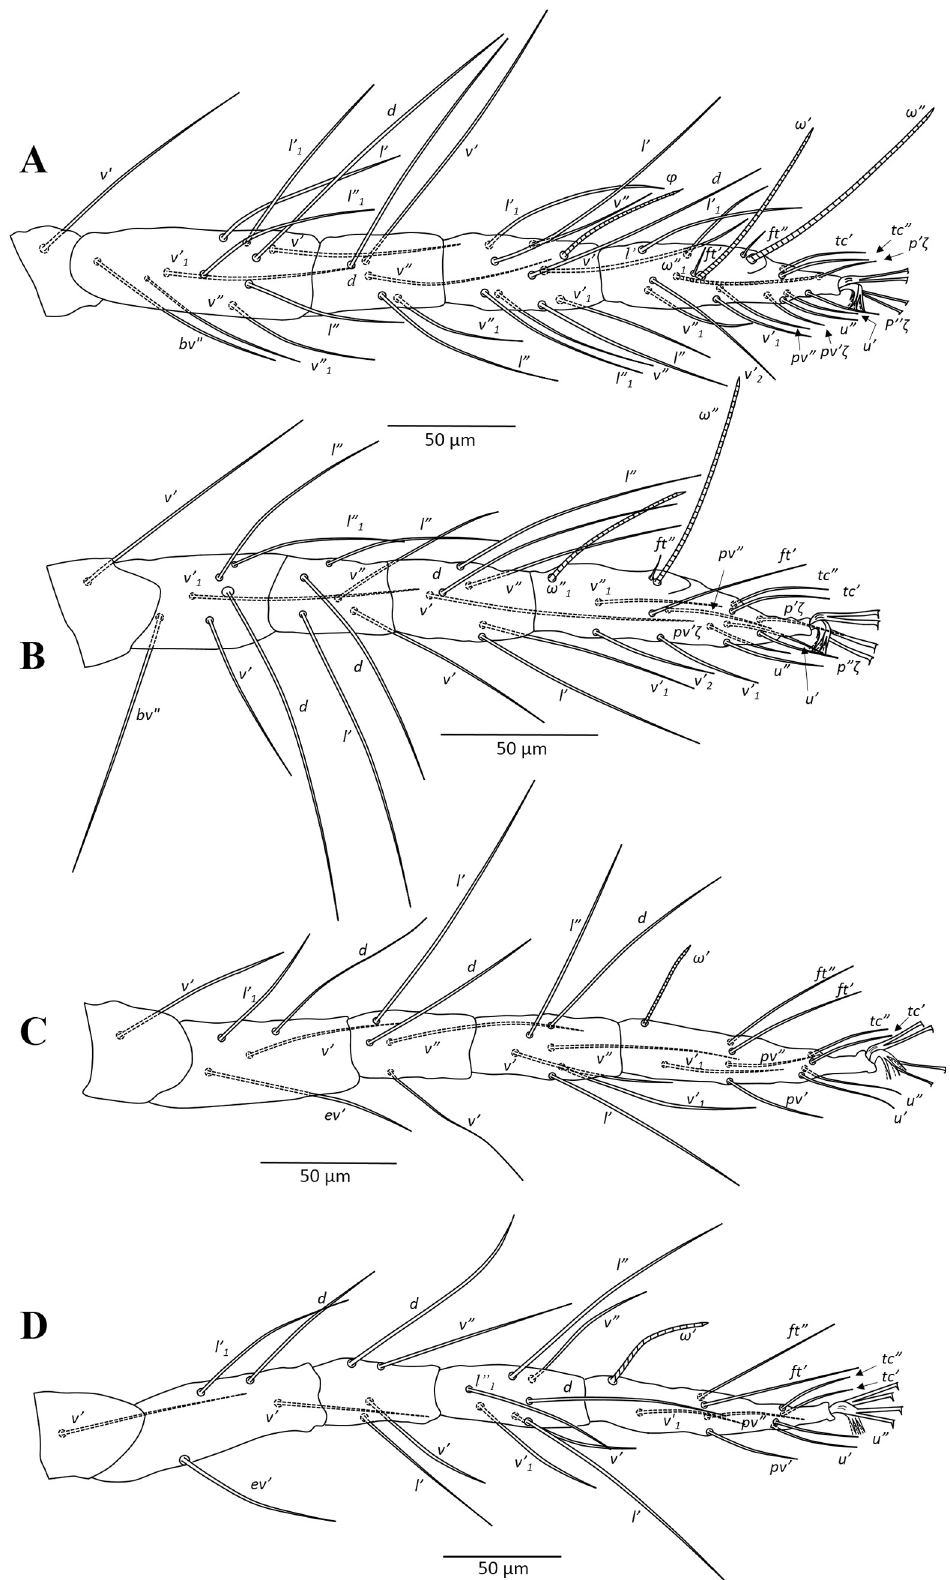
Fig 8. Amphitetranychus viennensis , female—A. Leg I, B. Leg II, C. Leg III, D. Leg IV.